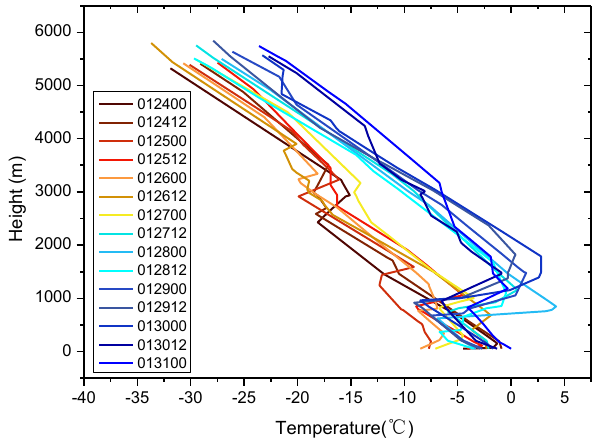
Figure 3. The temperature profiles during the observation period. The legend stands for UTC time. For example, 012400 means 00:00 on 24 January.